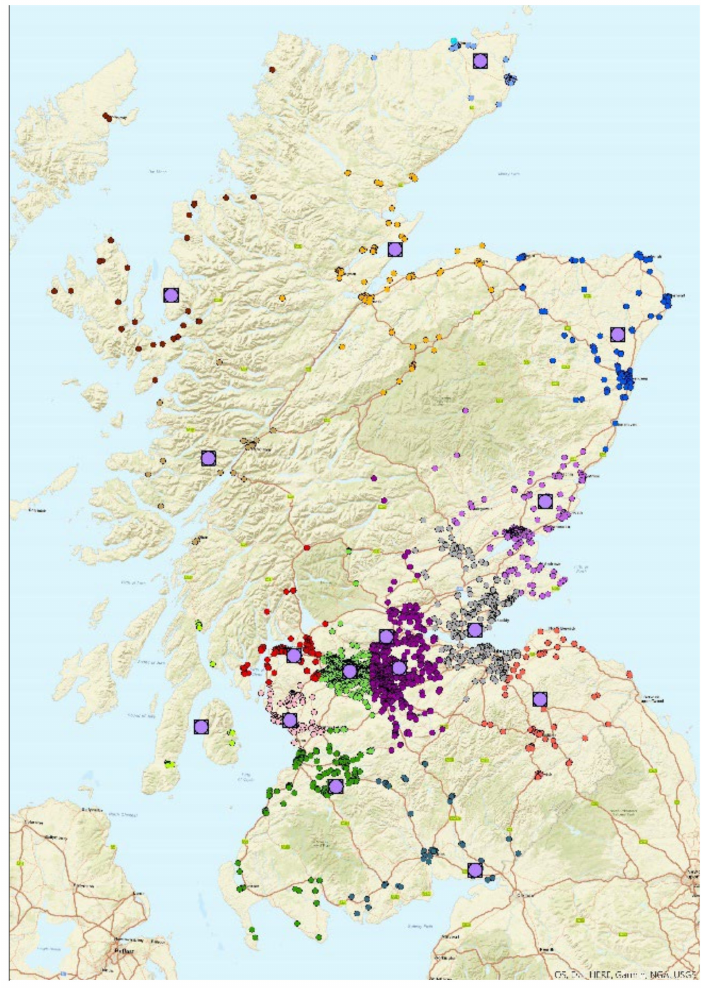
Figure 3. Clusters of marginal lands in Scotland. The small nodes depict the individual marginal fields spatially grouped by color. The big purple nodes depict the node centers of each colored